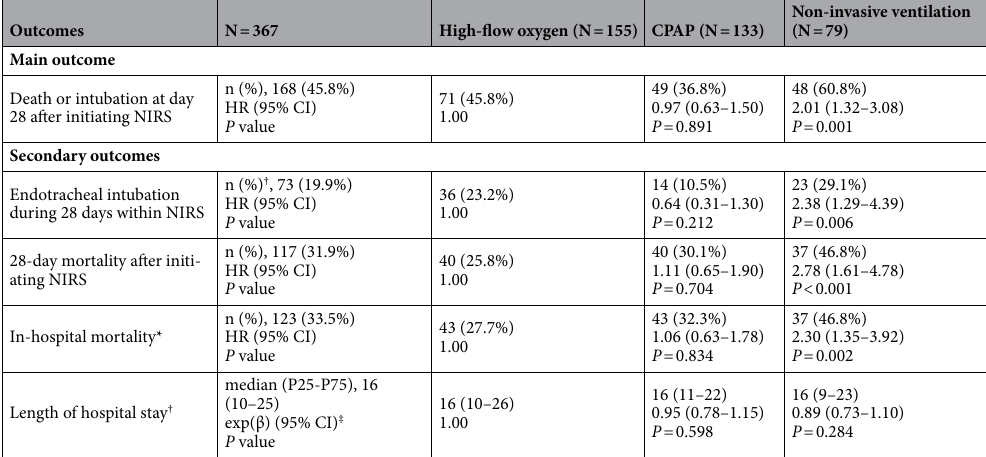
Table 4. Outcomes by non-invasive respiratory support group. CI confidence interval. HR Hazard ratio from multivariable survival model adjusted by age, sex, hospital, admission date (tertiles) and sleep apnea. P-value: Wald test. *In-hospital mortality: at any time during hospital stay, even if > 28 days after initiating NIRS. † Length of hospital stay: admission to discharge-or in-hospital death. ‡ exp(β): coefficient (exponentiated) from linear regression for Length of hospital stay (log-transformed) adjusted for the same variables as other models. exp(β) can be interpreted as % change in the geometric mean length hospital